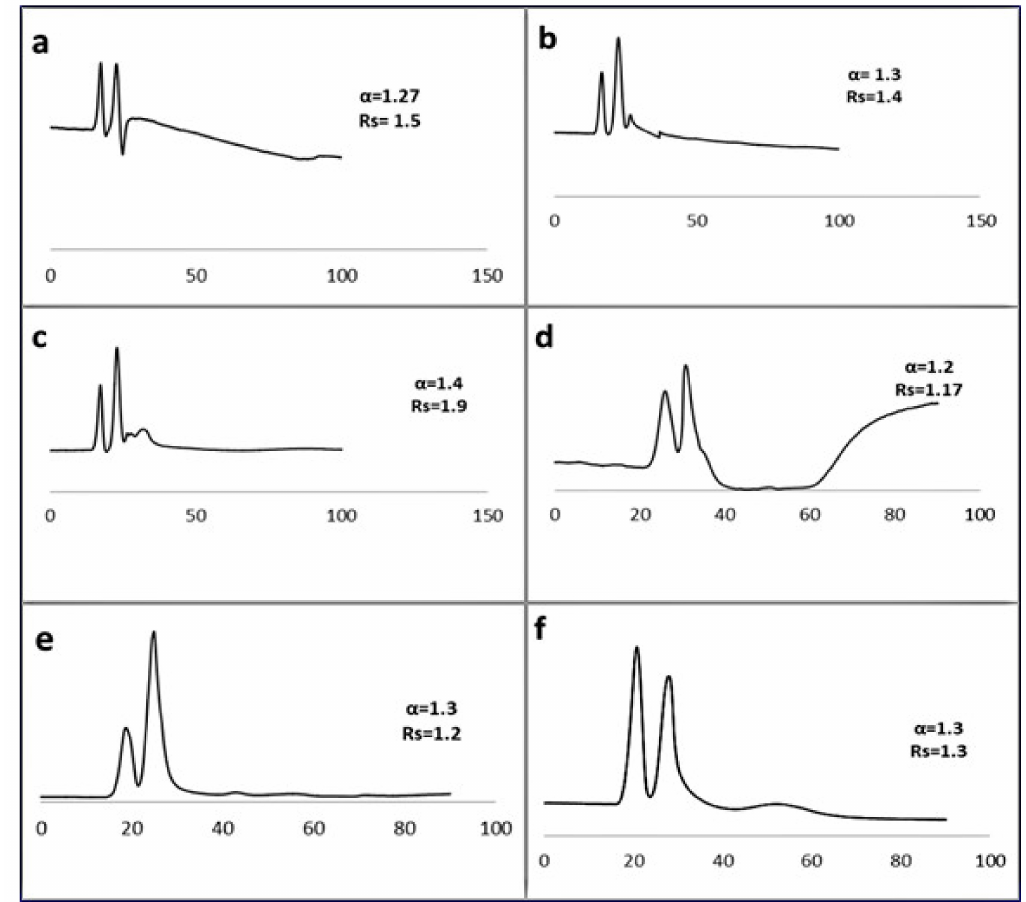
Figure 6. Enantioselective nano-lc separation of racemic Naftopidil ( a ), flavanone ( b ), pindolol ( c ) (Mobile phase: ACN/water 10:90 v/v ,), Atenolol ( d ), Ampicillin ( e ), and 4-hydroxy-3-methoxymandelic acid 35 ( f ) (Mobile phase: ACN/water 5:95 v/v on D2 capillary column (150 µ m ID, 25 cm length)). UV: 219 nm, flow rate: 1 µ